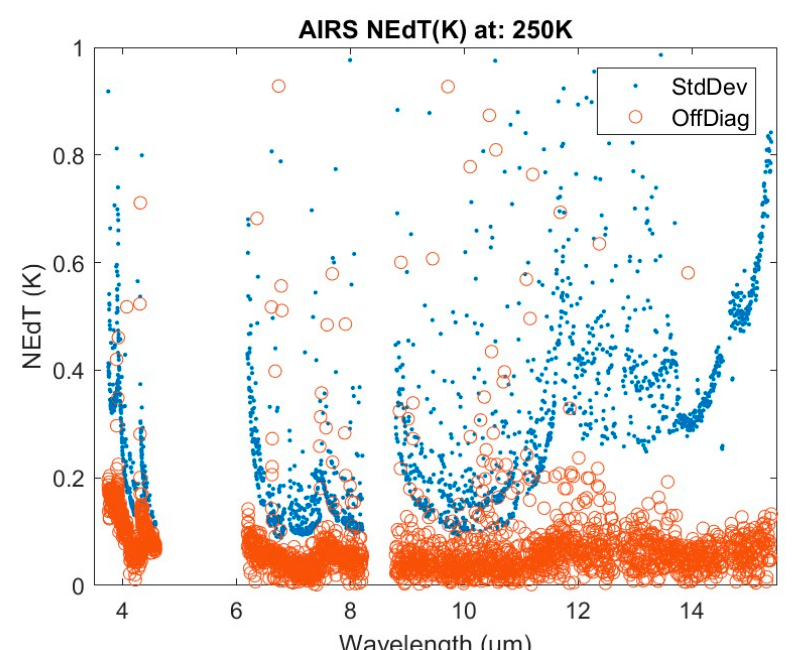
Figure 7. Noise equivalent differential temperature (NEdT) for AIRS at 250 K for uncorrelated (blue points) and correlated (red circles) noise. Correlated noise is considered a radiometric uncertainty.